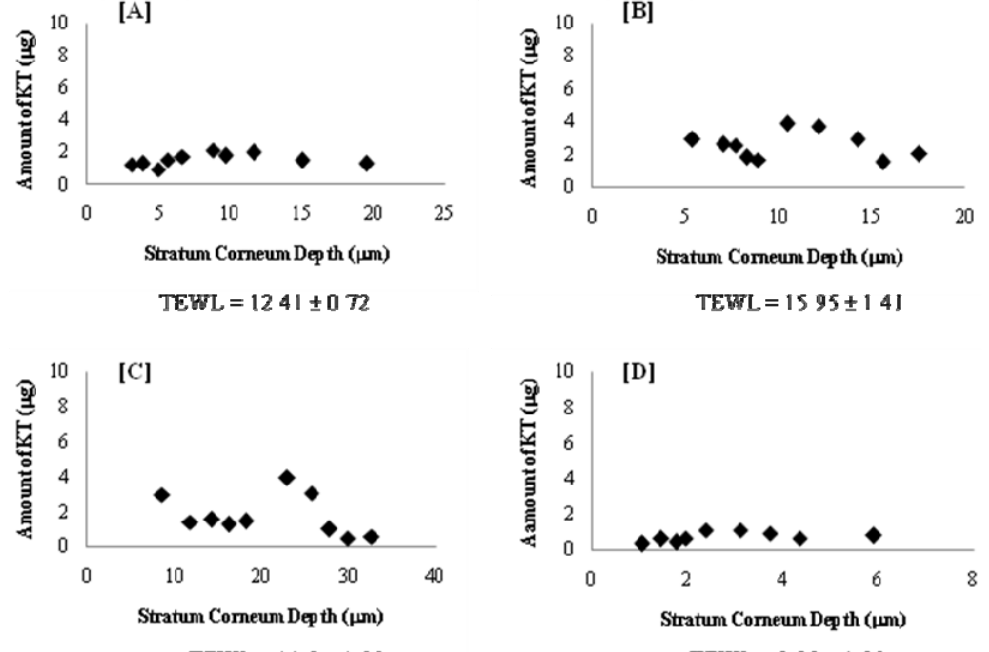
Figure 7. Amount of KT vs. stratum corneum depth after 1 hour of treatment for volunteers ( A ), ( B ), ( C ), ( D ), ( E ) and ( F ). TEWL (Transepidermal water loss, g/m 2 h) measurements were recorded before